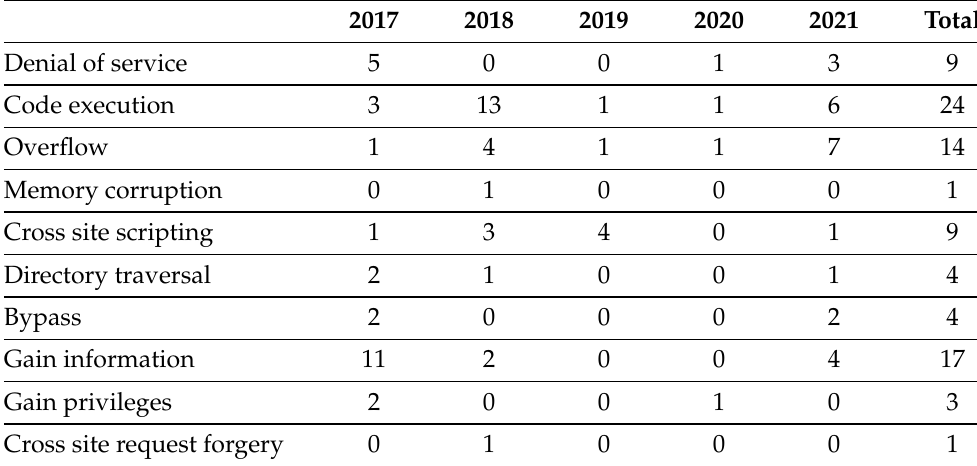
Table 4. Samsung’s